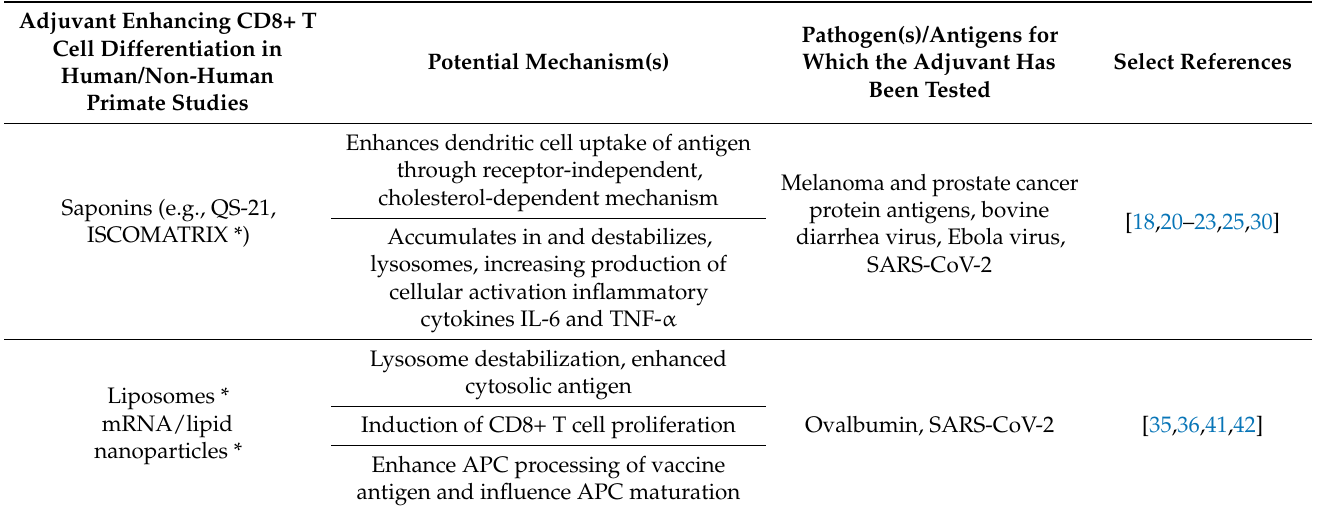
Table 1. Adjuvants enhancing CD8+ T cell differentiation in human/non-human primate